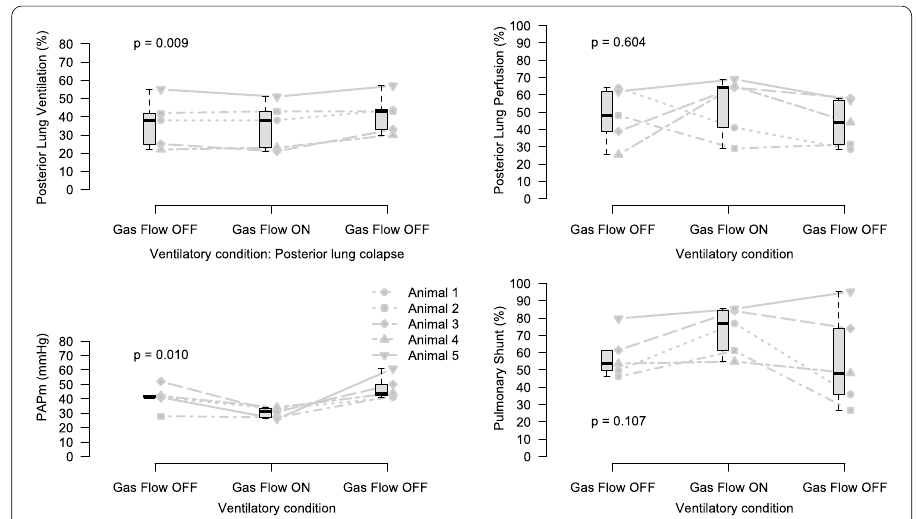
Fig. 3 Posterior lung ventilation in % of lung ventilation (top left); posterior lung perfusion in % of pulmonary blood flow (top right); mean pulmonary artery pressure (bottom left); pulmonary shunt (bottom right). Gas flow OFF denotes no ECMO support due the absence of gas flow. Gas flow ON denotes the initiation of ECMO